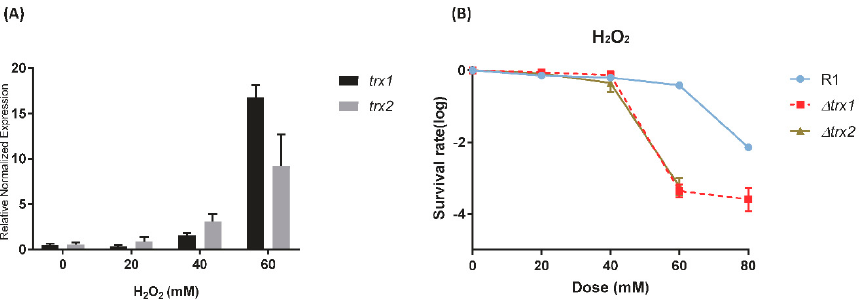
Figure 1. Transcription and phenotype of ∆ drtrx1 and ∆ drtrx2 under H 2 O 2 stress. ( A ) D. radiodurans was exposed to H 2 O 2 at the indicated concentrations (0, 20, 40, 60 mM), and qRT-PCR analysis was performed to determine drtrx1 and drtrx2 transcription level. The fold increase of transcription was determined by setting the expression level of the non-treated control to 1. ( B ) Survival curves of D. radiodurans wild-type, ∆ drtrx1 , and ∆ drtrx2 treated with different concentrations of H 2 O 2 (0, 20, 40, 60, and 80 mM) . The cells spotted on TGY plates and colonies were counted after 3 d. Error bars indicate the standard deviation for three experimental